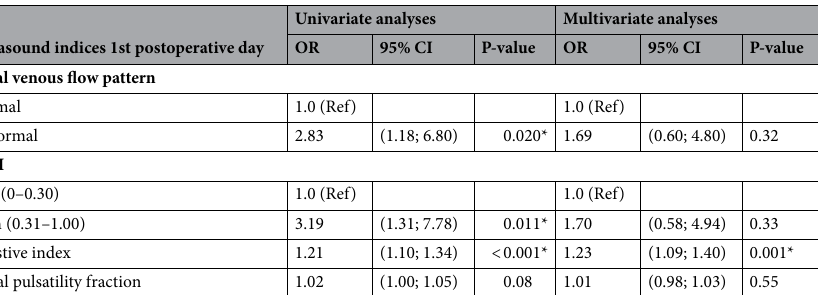
Ultrasound indices 1st postoperative